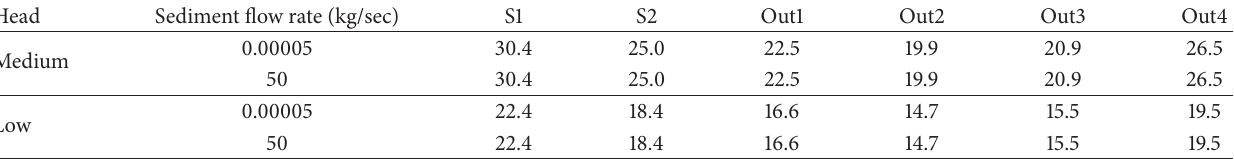
Table 8: Velocity at different locations of Tunnel 3 under different head and varying sediment flow